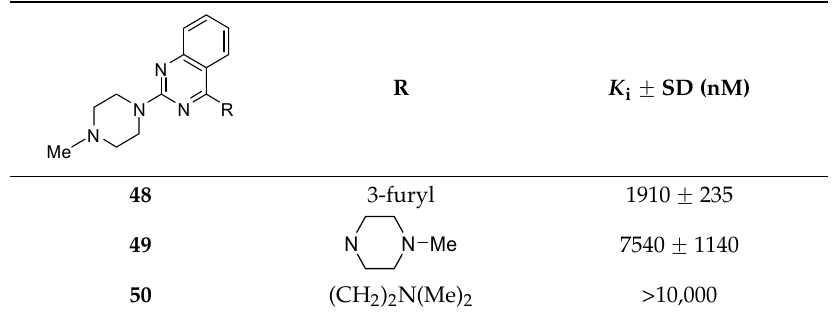
Table 3. Affinities of substituted quinazolines 48 – 50 for 5-HT 7 receptor.